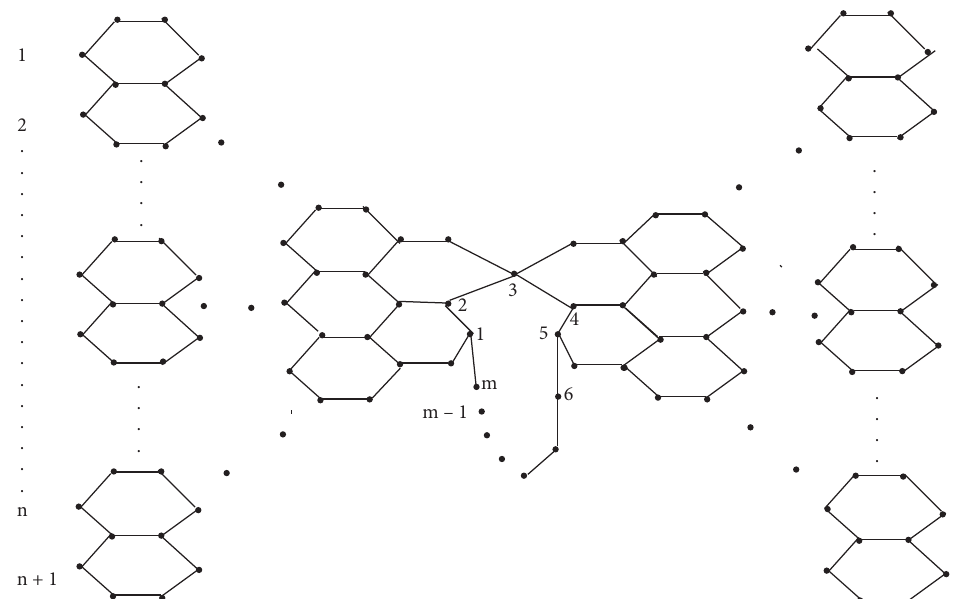
Figure 2: Generalized hourglass carbon nanocone HGSCNC ( n, m ) .